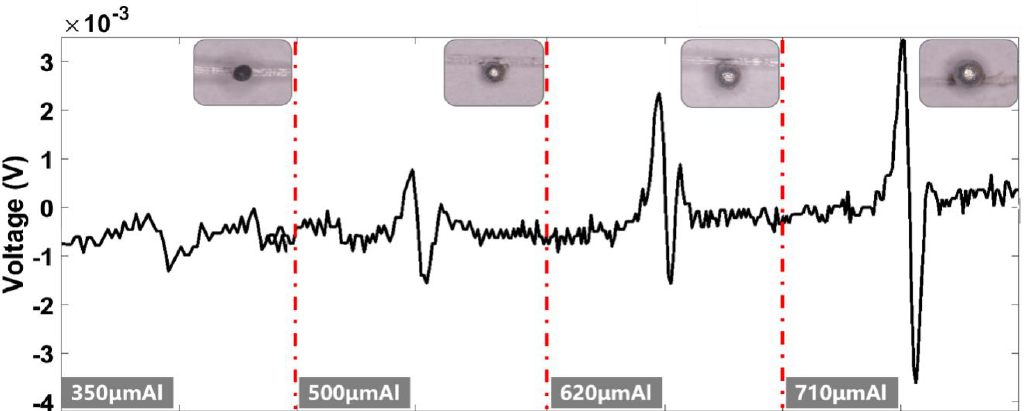
Figure 7. Inductive electric potential generated by different particle sizes of aluminum particles.